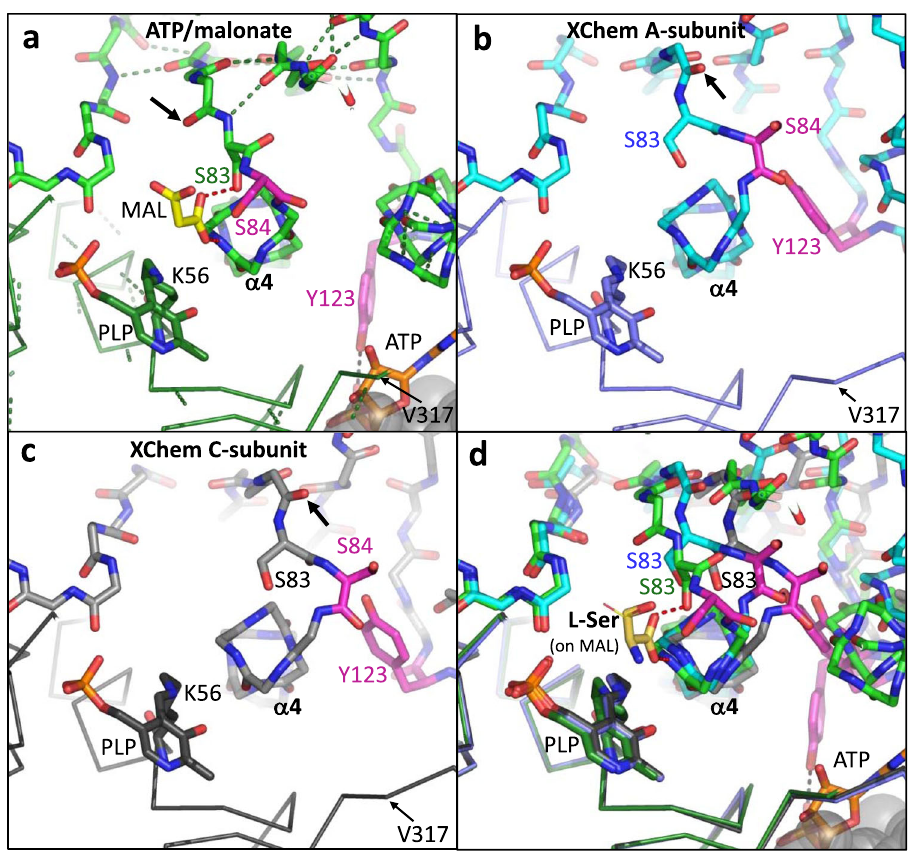
Fig. 10 Comparison of human SR structures viewed from N-terminal end of α 4 helix. a View of the malonate (yellow carbons)/ATP (oranges carbons) hSR complex (6ZSP). SR (green carbons) is shown with side-chains of Ser 84 and Tyr 121 (magenta carbons) highlighted. The second subunit in the dimer is partially visible in the bottom right-hand corner (grey semi-transparent spheres). The side-chain of Ser 83 makes a hydrogen bond (dotted red line) to the malonate and the main-chain NH of His 87 also donates a hydrogen bond to the malonate. The carbonyl oxygen of His 82 is arrowed. b Equivalent view of an XChem A subunit. The carbonyl oxygen of His 82 is arrowed. c Equivalent view of an XChem C subunit. d Superposition of structures from ( a ), ( b ) and ( c ) on the large subunit (C α traces). L-serine (sticks - yellow carbons) has been modelled on the malonate (thin yellow lines - largely hidden under L-